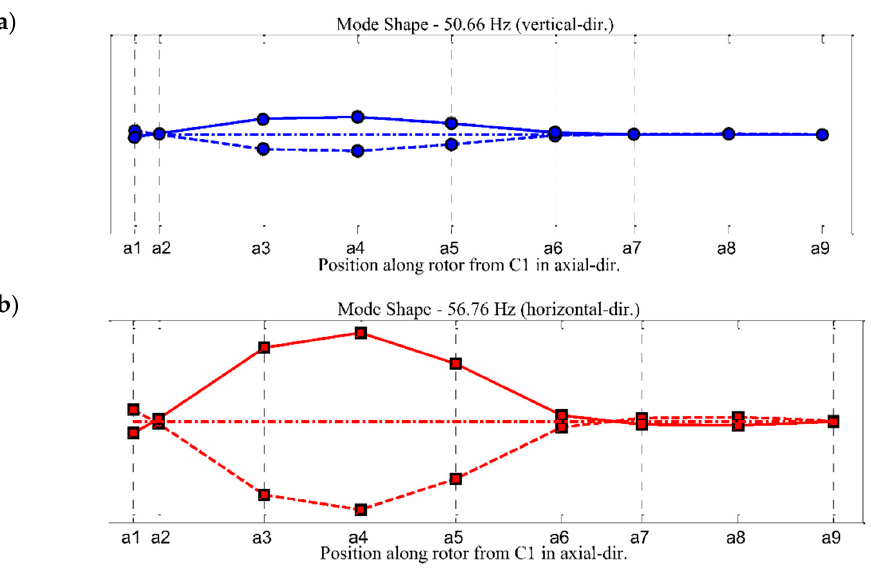
Figure 2. Experimental mode shapes: ( a ) 50.66 Hz, vertical direction dominant; ( b ) 56.76 Hz, horizontal direction dominant [20].